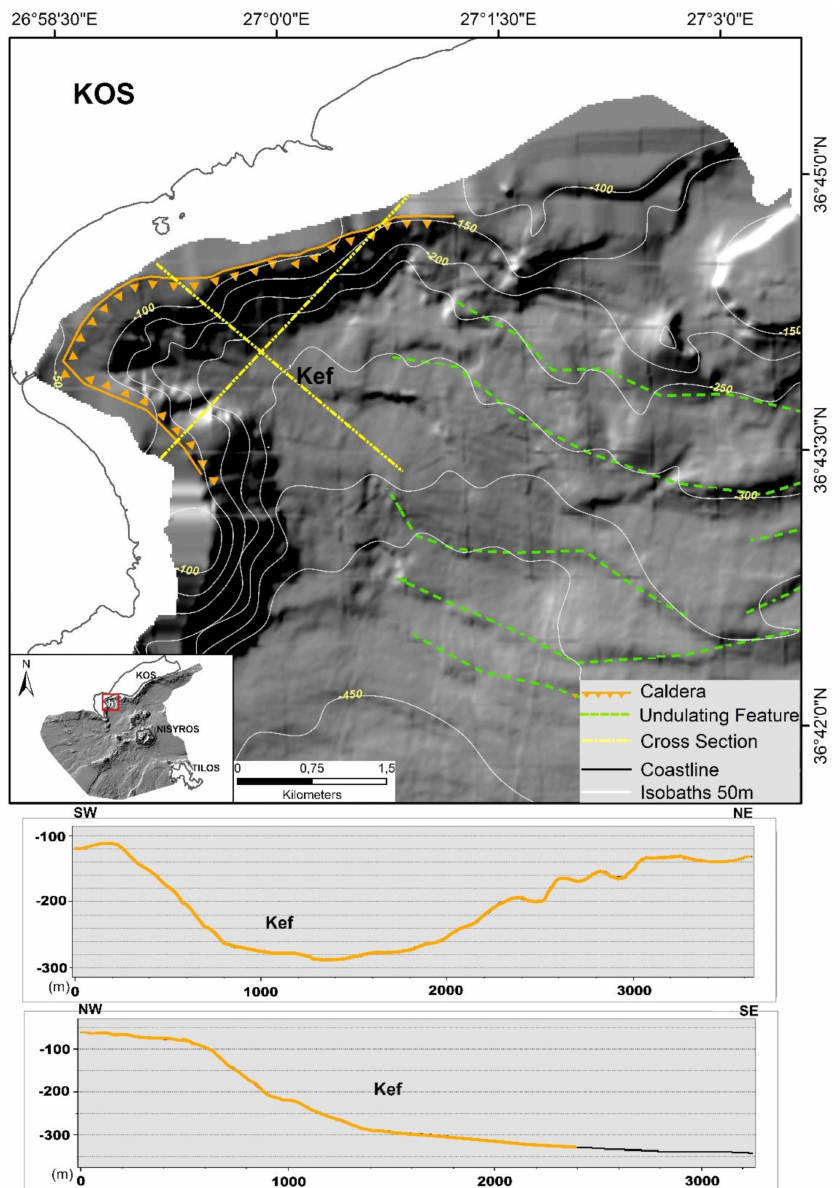
Figure 9. Half of the Kefalos caldera (Kef) located at the northwestern part of the Western Kos Basin (Figure 3) is expanded offshore and characterized by steep slopes. Undulating features are also illustrated with green dashed lines showing the direction of a radial flow. The volcanic relief of Kefalos (Kef) submarine caldera is depicted in topographic